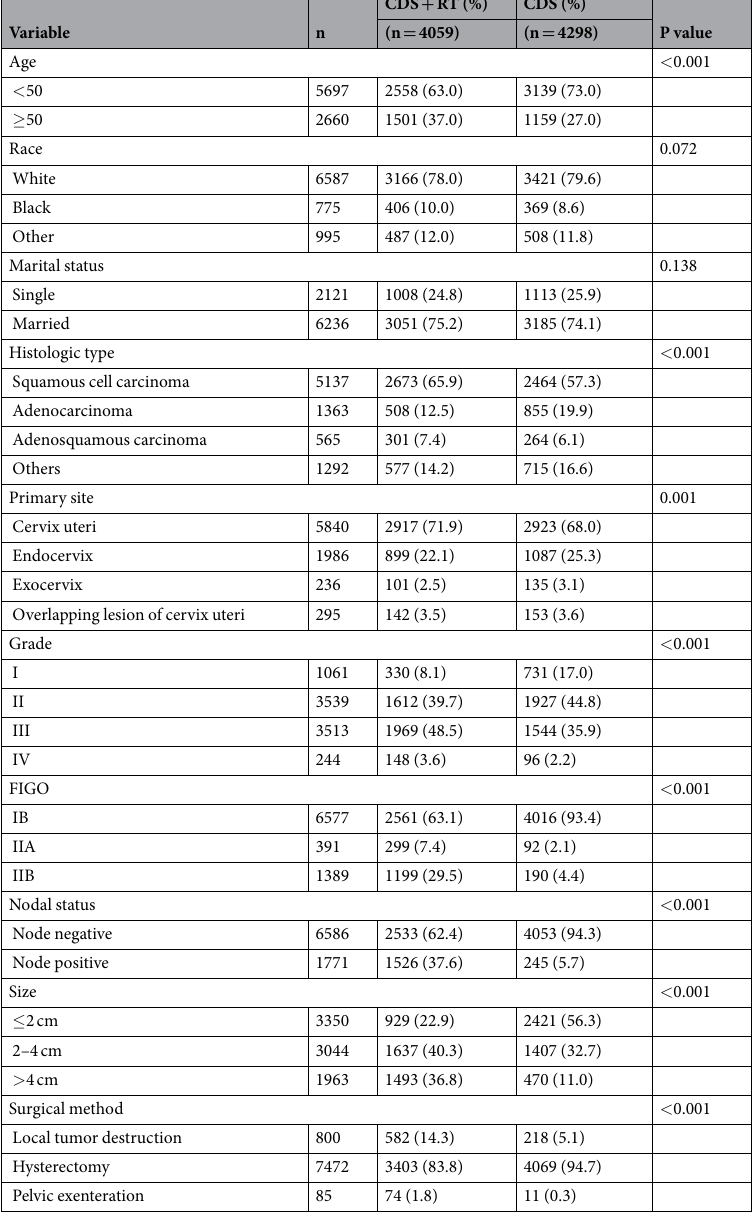
Table 1. Characteristics of Patients. CDS: cancer-directed surgery; RT: radiotherapy; FIGO: International Federation of Gynecology and